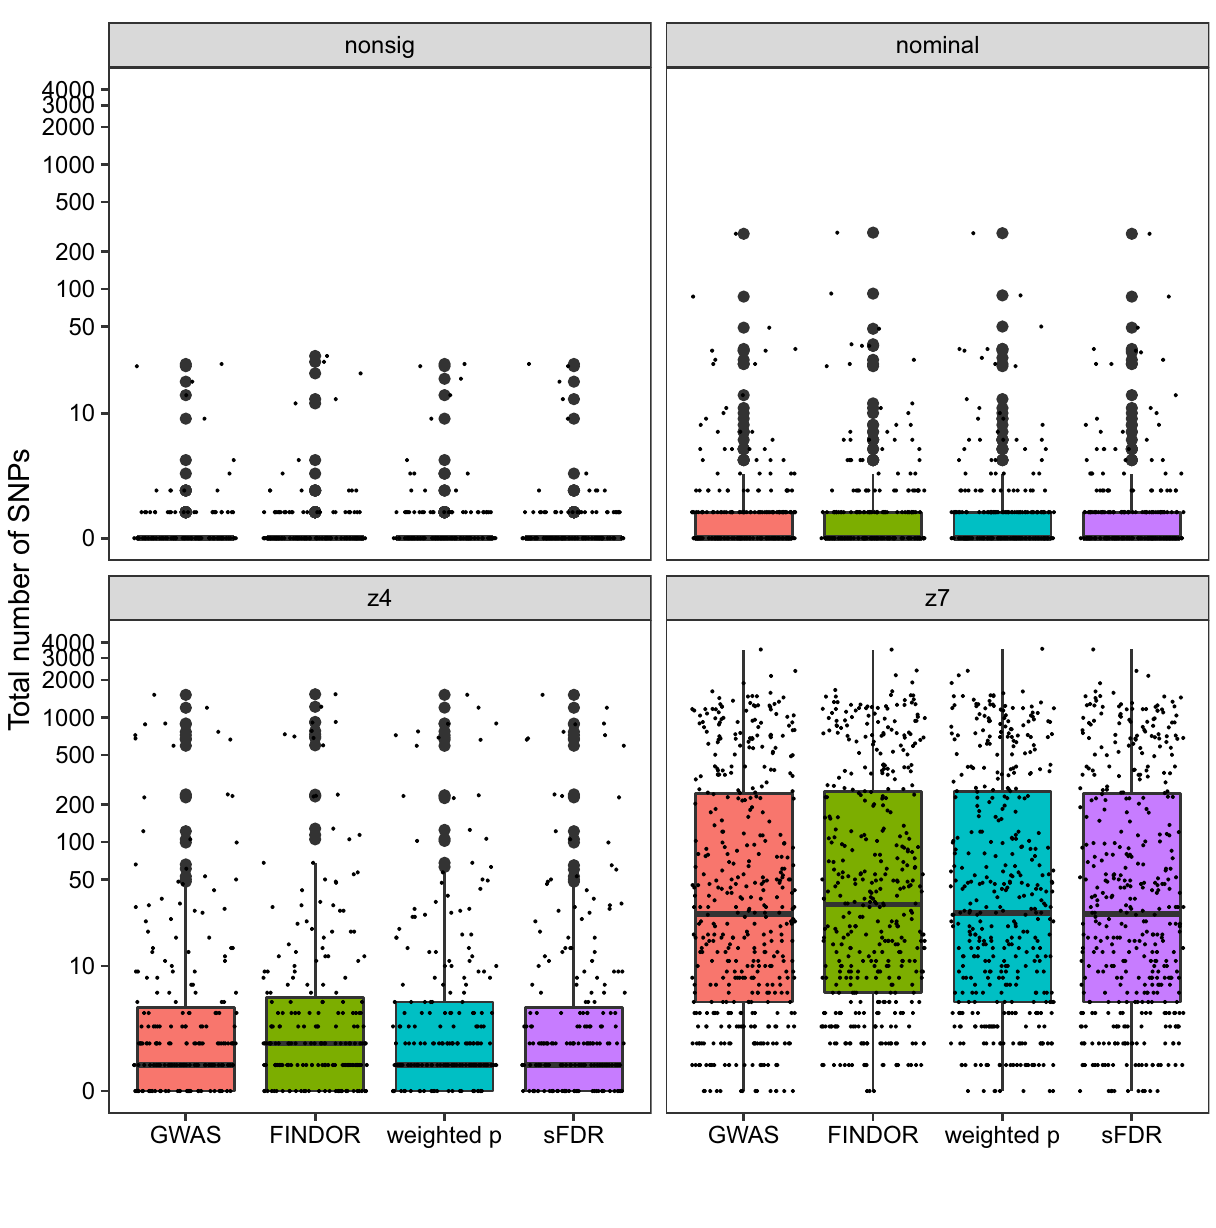
Figure 4. The total numbers of genome-wide significant independent loci of the UK Biobank GWAS application study, before and after data-integration with functional annotations, stratified by the four phenotype categories. In each figure, the total number of significant loci identified based on the UK Biobank GWAS data alone serves as a baseline. The GWAS baseline box-plot is followed by the box-plots for the total numbers of significant loci after integrating the UK Biobank GWAS summary statistics with functional annotations using FINDOR (using 75 individual annotation scores), and the weighted p value and stratified FDR control methods (each using the CADD meta-score), analyzing 7,895,174 variants for each of the 1132 UK Biobank traits. The 1132 traits were rated by Nealelab as having medium to high confidence for their heritability estimates, and they fall into four categories: nonsig (182 traits; heritability testing p value p > 0.05 ), nominal (277 traits; p < 0.05 ), 5 ), and z7 (438 traits; p < 1.28 12 ). Independent loci were defined using 10 10 z4 (235 traits; p < 3.17 − − × × PLINK’s LDclumping algorithm with a 1 Mb window and an r 2 threshold of